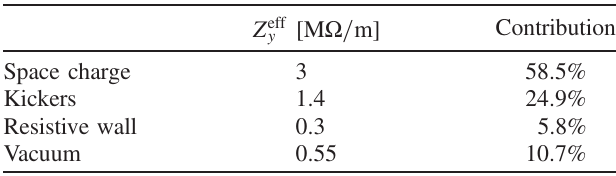
TABLE VII. Contribution of the different machine elements to the vertical effective impedance budget 2